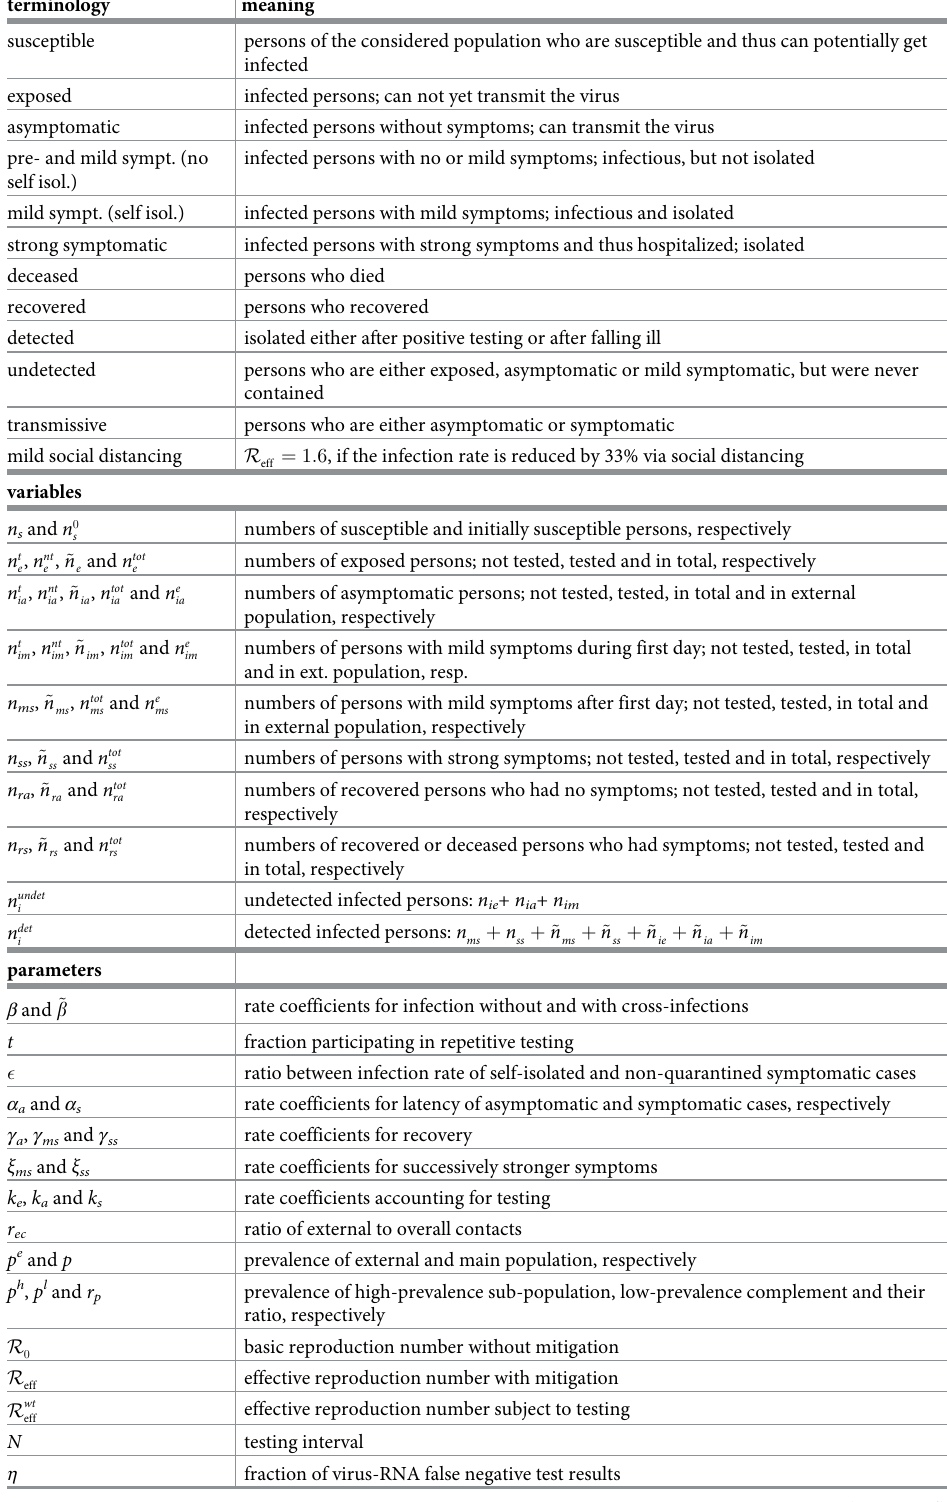
Table 1. Terminology and nomenclature of model parameters and